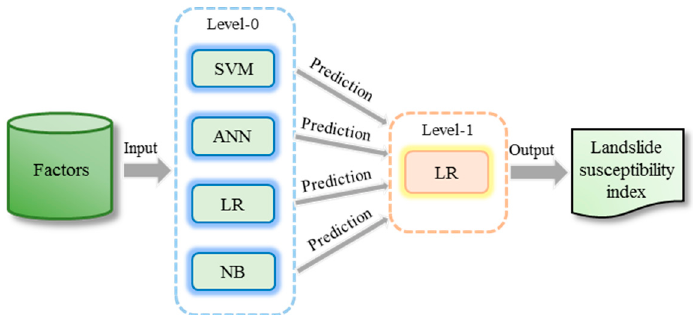
Figure 5. Stacking-based ensemble framework for landslide susceptibility modeling. SVM: support vector machine; ANN: artificial neural network; LR: logical regression; NB: naive Bayes.